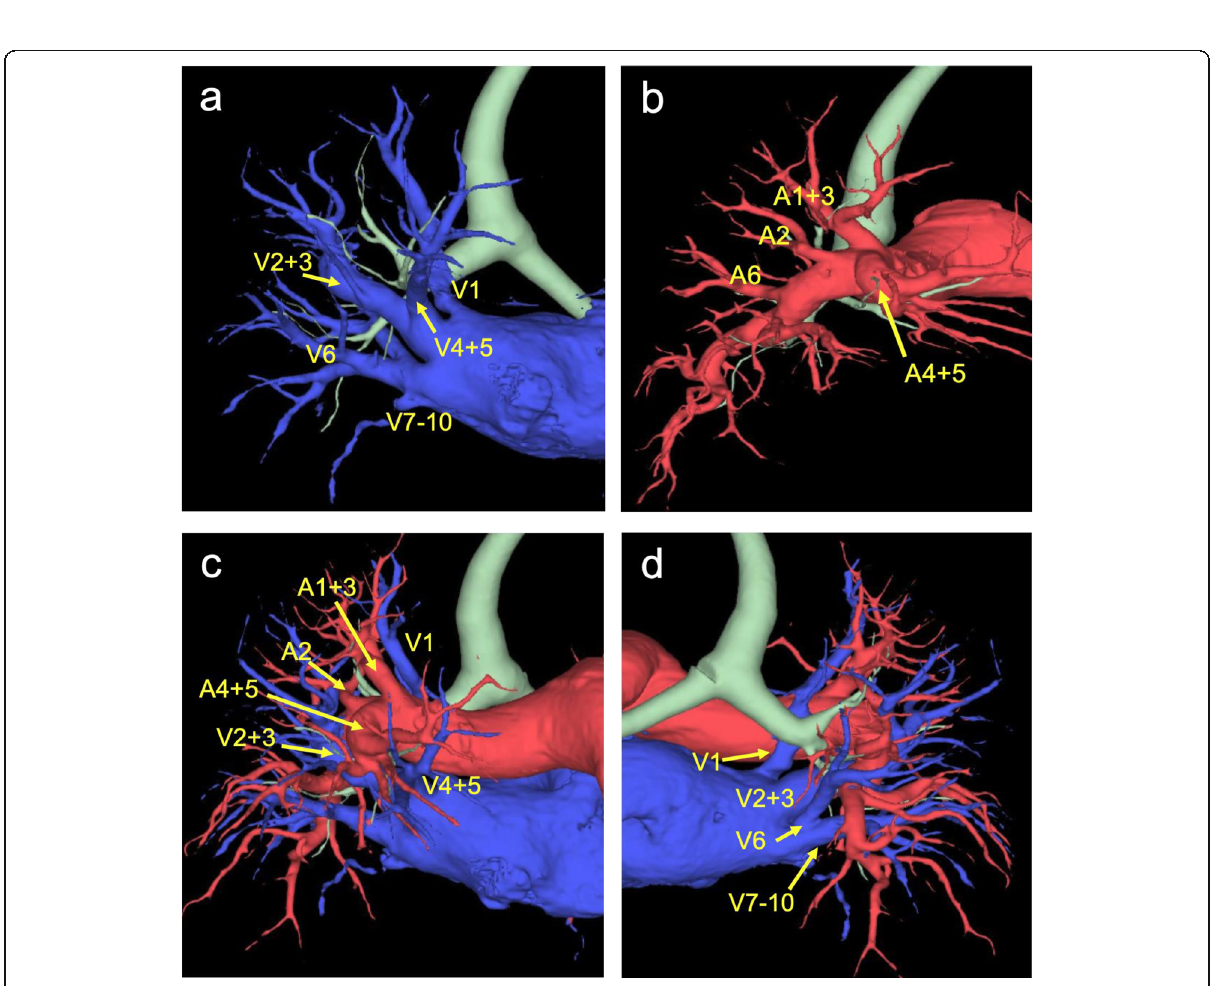
Fig. 2 The whole image of the right pulmonary vein is observed with the 3D image. The segmental vein (V1) flowed into the left atrium alone. The segmental vein (V2+3) joins the segmental vein (V4+5) from the back of the segmental vein (V4+5) flows into the left atrium ( a ). In observation of the 3D image, the whole image of the pulmonary artery was as usual ( b ). At the hilum, the main trunk of the pulmonary artery is above the segmental veins (V1 and V2+3), but between the lobes, the segmental vein (V2+3) is over the main pulmonary artery ( c ). From the dorsal view, the segmental vein (V1) exists in front of the right upper lobe bronchus ( d